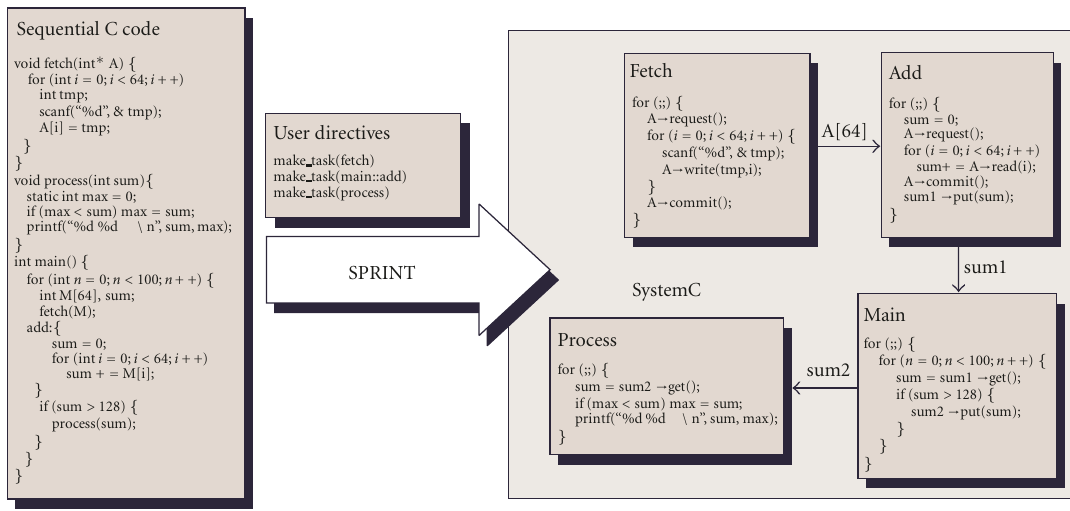
Figure 2: A small example illustrating how SPRINT transforms sequential code to parallel SystemC code with user specified task bound- aries. The example includes block FIFO (A[64]) and scalar FIFO (sum1,sum2) channels including a channel (sum2) with a data-dependent communication